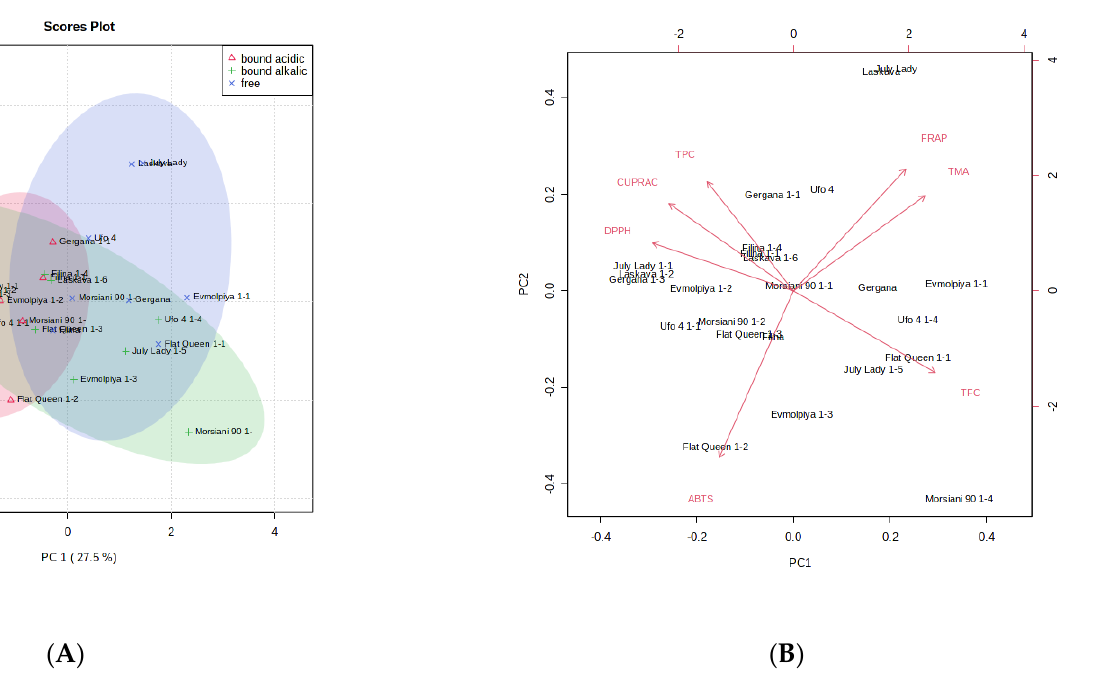
Figure 4. Principal component score plot ( A ) and eigenvector load values ( B ) of TPC, TMA, TFC, and AOA assays of peach ( Prunus persica L.) peels for the eight peach peel varieties. The statistically independent variables (assays or compounds) can be drawn from the heatmaps (Figures 4 and 5). Peels from each variety are characterized with different linear relationships. Considering the clade arrangement in the Figures, it can be assumed that phenolic compounds and antioxidant assays lead to more distinct differences between the established